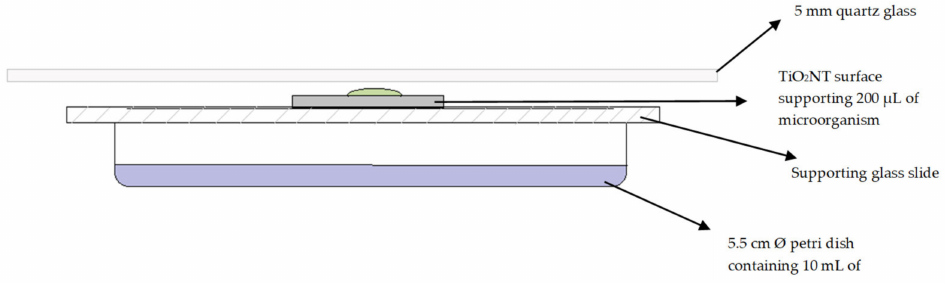
Figure 2. Diagrammatic representation of the experimental set up used for the determination of antimicrobial activity of the TiO 2 -NT surfaces.